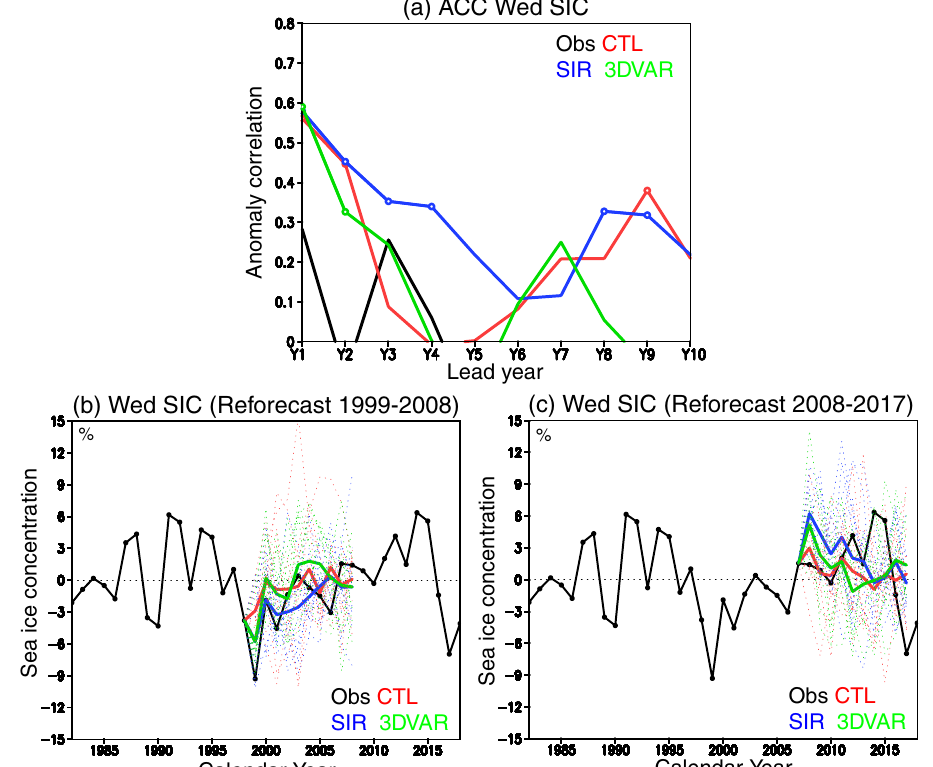
Fig. 6 Prediction skills of decadal sea ice concentration (SIC) variability in the Weddell (Wed) Sea. a Same as in Fig. 2a, but for the ACC of the SIC anomalies in the Weddell Sea (Wed; 60° − 0°W, 65° − 55°S) as a function of lead years. b Same as in Fig. 2b, but for the time series of the SIC anomalies in the Wed region. A black line shows the observed SIC anomalies, while colored lines show the SIC anomalies predicted from March 1st 1999 in the CTL (red), SIR (blue), an 3DVAR (green) experiments. We calculated the anomalies with respect to the period of 1982 – 2018. c Same as in b , but for the SIC anomalies (in %) predicted from March 1st